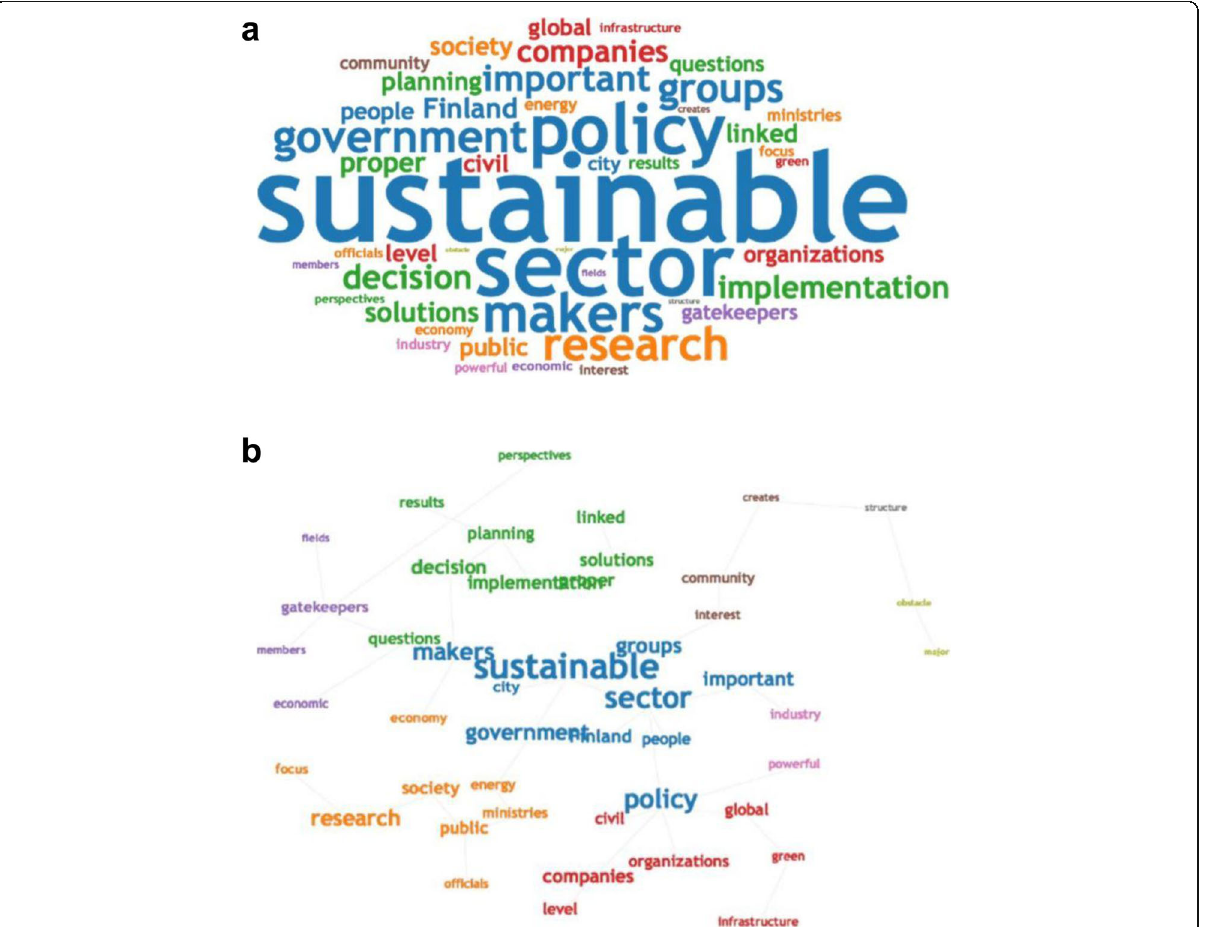
Fig. 3 Examples of network analysis of the answers to the